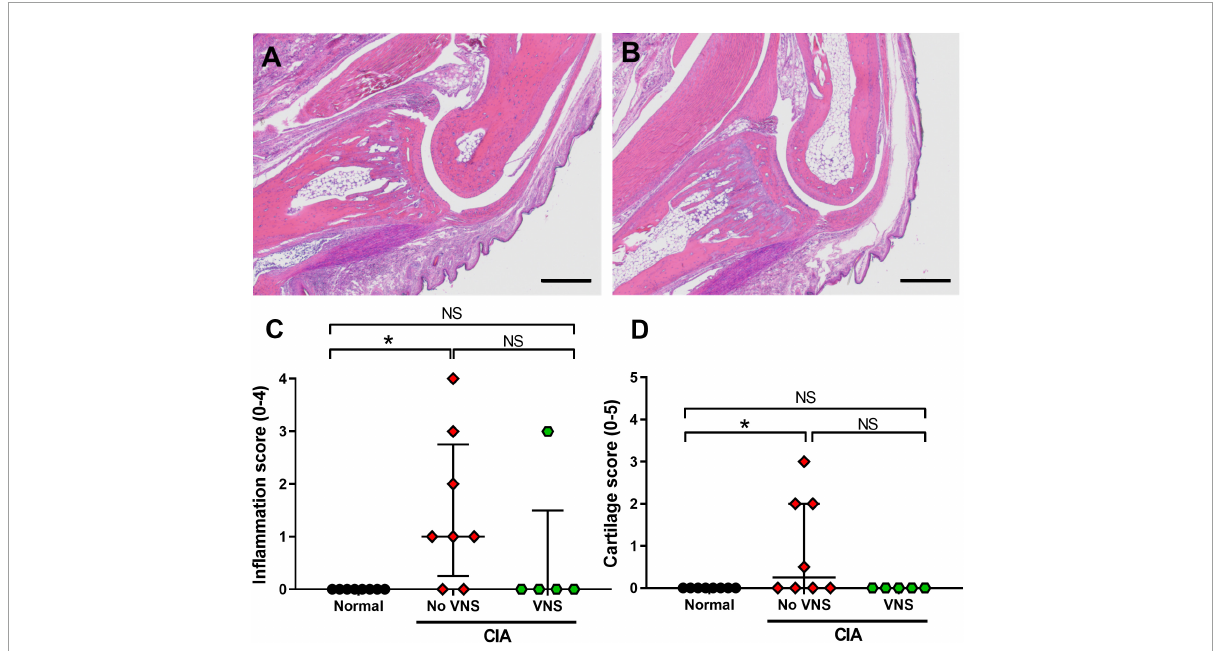
FIGURE3 Effects of vagus nerve stimulation improves histopathology of interphalangeal joints at 17 days following collagen injection. (A) Representative image of inflammation in and around the distal interphalangeal (IP) joint from an unstimulated collagen-induced arthritis (CIA) rat shows moderate neutrophil infiltration. (B) The IP joint of stimulated CIA rats had little to no inflammation within the joint space. (C) Semi-quantification of inflammation histological score (0–4) using H&E staining. (D) Semi-quantification of cartilage damage (0–5). Data show median ± interquartile range and symbols are from individual rats. Differences between normal ( n = 8), no vagus nerve stimulation (VNS) ( n = 8), and VNS ( n = 5) groups was analyzed using Kruskal–Wallis one-way ANOVA and Dunn’s post-hoc test. Significant differences of P < 0.05 are indicated by “*” and non-significant differences as “NS.” Scale bars in panel (A) and (B) are: 500 µ